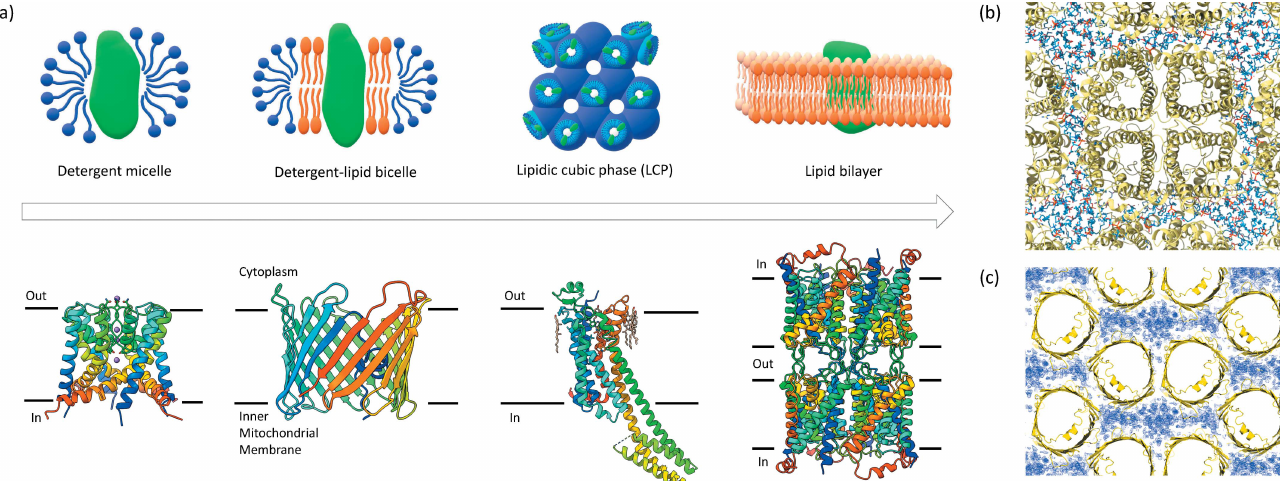
Figure 6 Examples of membrane protein crystallization modalities and structures solved. ( a ) Membrane protein structure determination in MicroED in a lipid and/or detergent environment mimicking the lipid bilayer. The structure of the NaK ion channel was determined from detergent micelles (Liu & Gonen, 2018), mVDAC from lipid bicelles (Martynowycz et al. , 2020), the A 2A -receptor from LCP crystals (Martynowycz, Shiriaeva et al. , 2021), whereas aquaporin-0 (AQP0) was determined from double-layered crystals of the protein embedded in lipid bilayers using electron diffraction (Gonen et al. , 2005). ( b ) Top view showing the electron crystallography structure of AQP0 resolved lipid-protein packing interactions between the tetramer (yellow) and the surrounding lipid molecules (blue). ( c ) Top view showing the MicroED structure of mVDAC and the crystal packing of the monomers (yellow) where the map (blue) in between the barrels indicates the space is likely to be occupied by the lipid